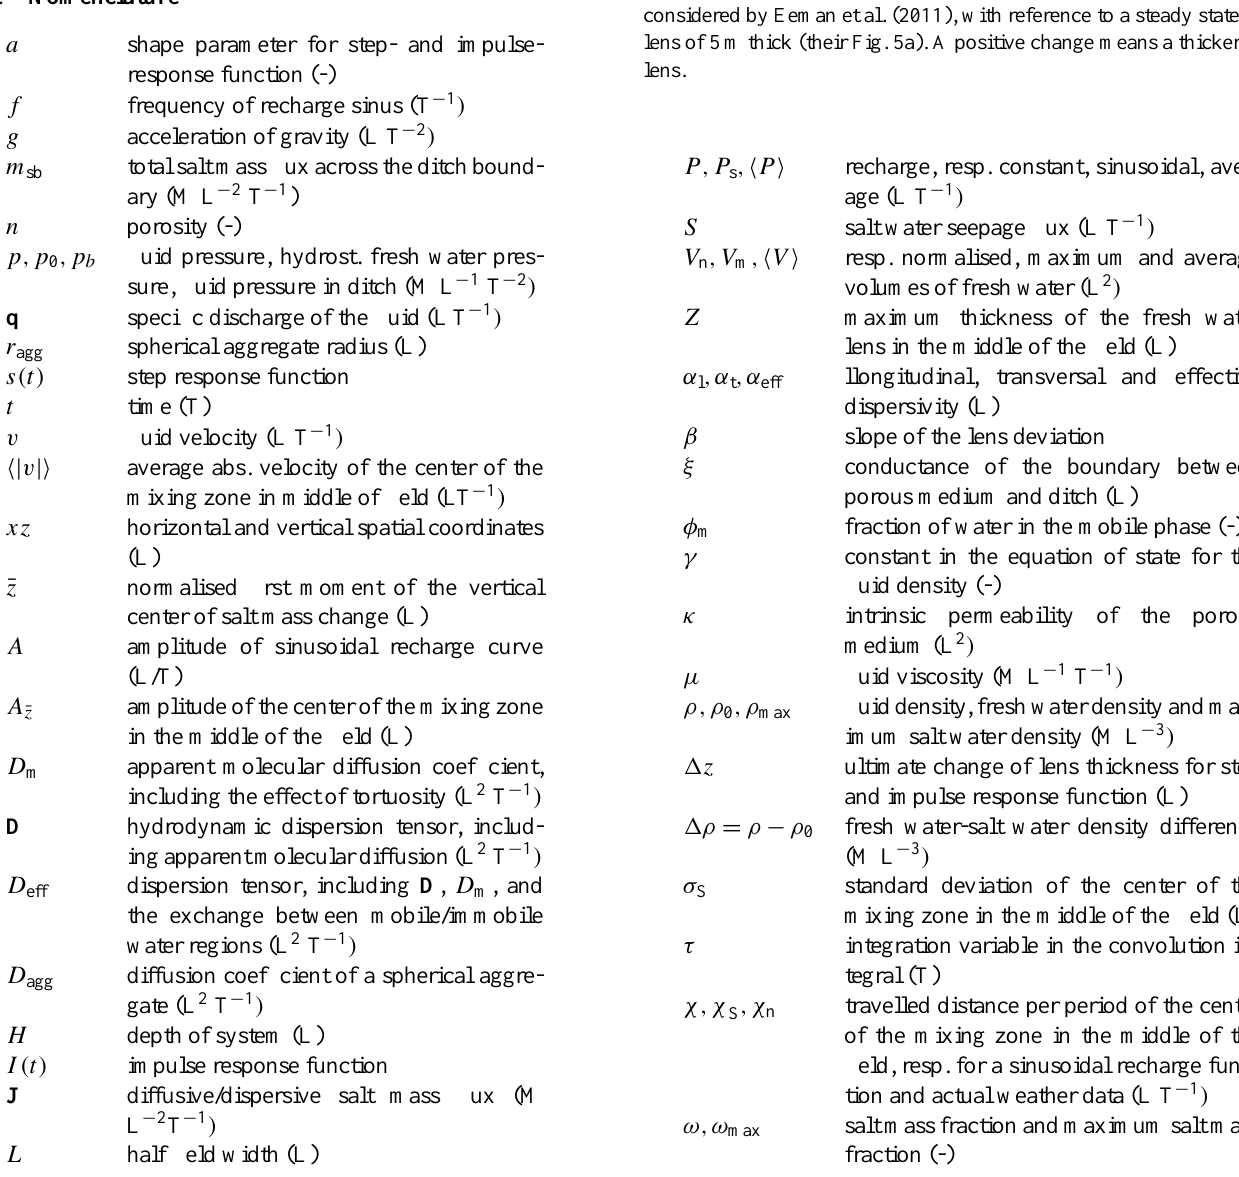
The sensitivity of the steady state interface position for the groups